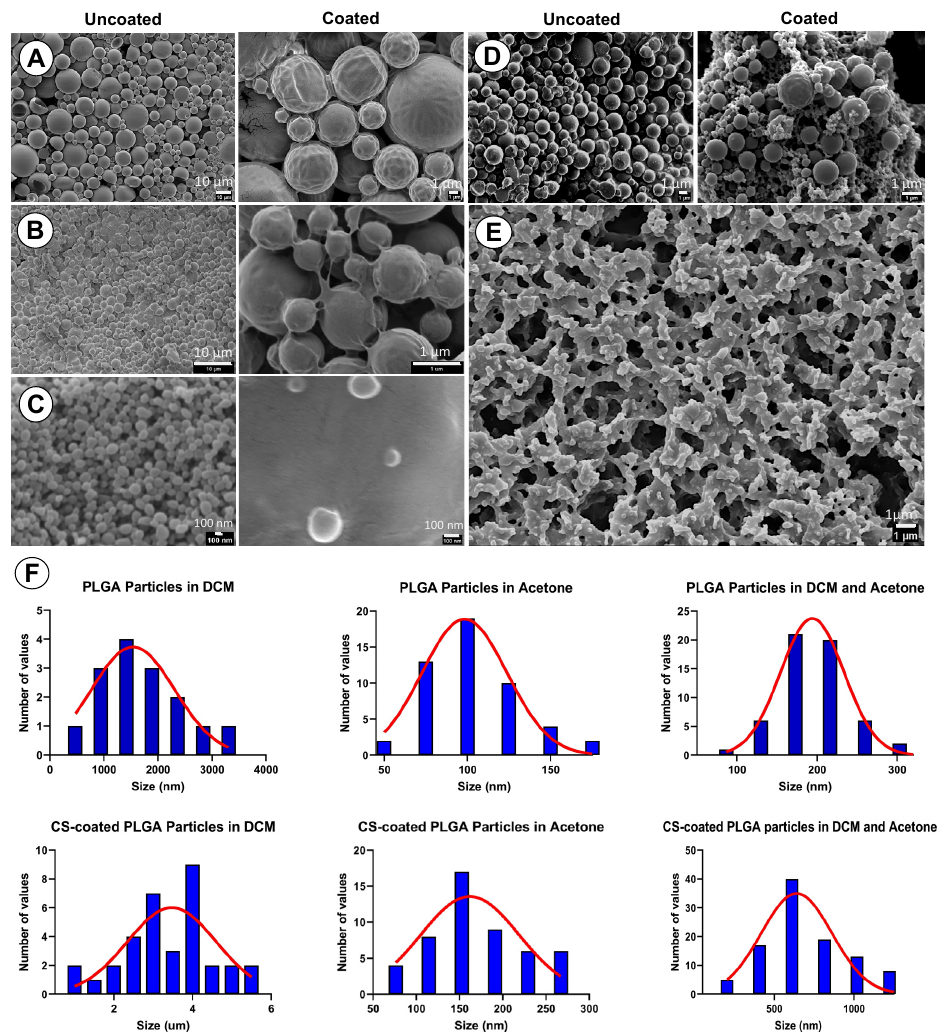
Figure 4. SEM micrographs showing the PLGA particles prepared using different conditions. ( A ) Uncoated and CS-PLGA particles prepared by conventional method. ( B ) Uncoated and CS-PLGA particles prepared by microfluidics using DCM as EO solvent. ( C ) Uncoated and CS-PLGA particles prepared by microfluidics using acetone as EO solvent. ( D ) Uncoated and CS-PLGA particles prepared by microfluidics using a DCM: acetone (1:10) as EO solvent. ( E ) Scaffold structure of chitosan. ( F ) Histogram of the actual particle size distribution in the EM images analyzed using ImageJ software.